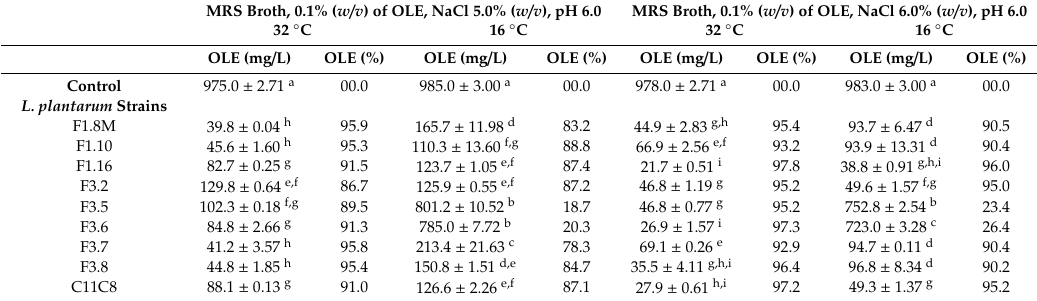
Table 2. Detected Values of Oleuropein (OLE) (Expressed as mg / L) and Percentage of Degraded OLE from Strains Inoculated in Modified MRS Medium and Incubated at Di ff erent Temperatures (32 ◦ C and 16 ◦ C).